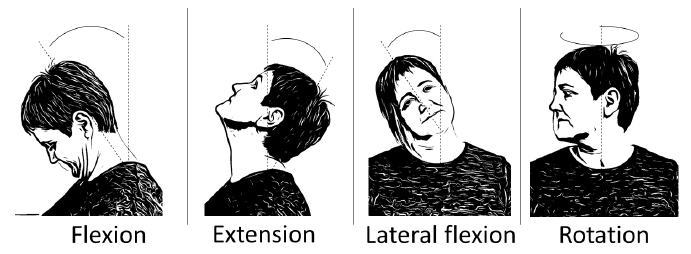
Figure 1. Movements of the